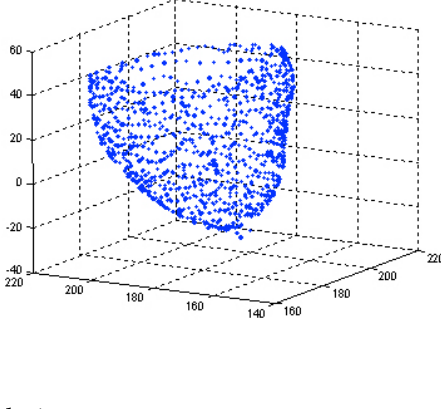
Figure 1. An example of the LV endocardium point model at one time